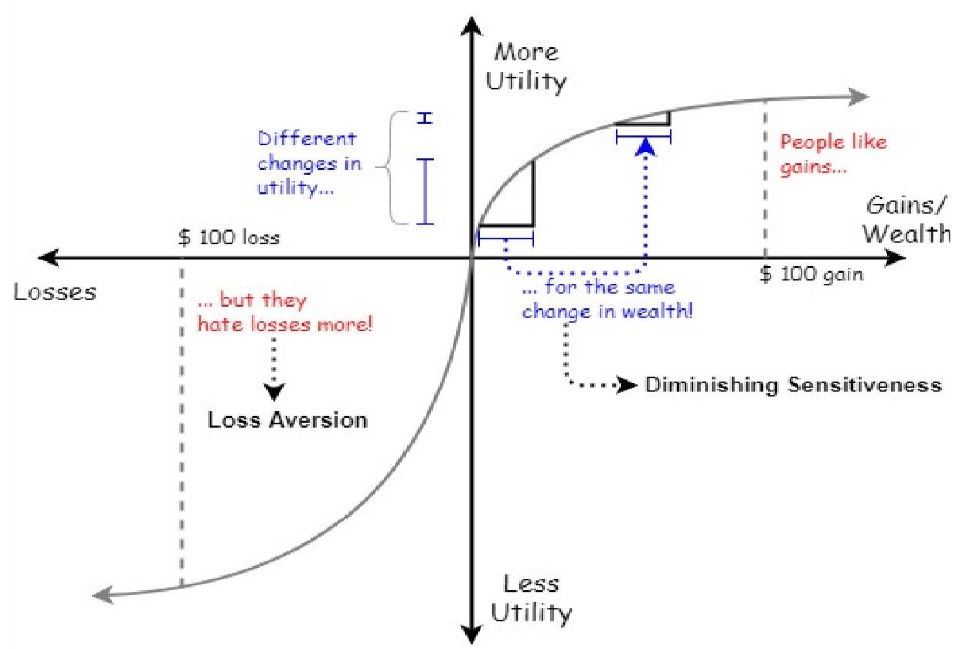
Figure 1. S-shaped curve of prospect theory. Diminishing sensitivity: as wealth grows, the impact of a given increment of wealth falls. Loss aversion: individuals respond asymmetrically to gain and losses.